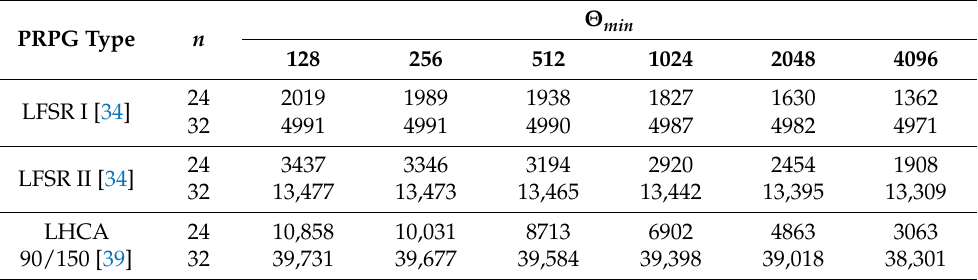
Table 3. The maximum numbers of scan paths to be fed from LFSR + PS or from CA + PS structures for various phase shifts Θ min .